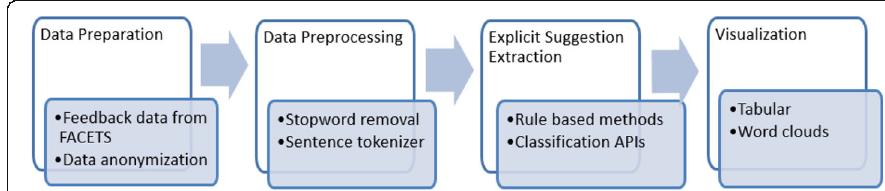
Fig. 5 Solution model for suggestion extraction